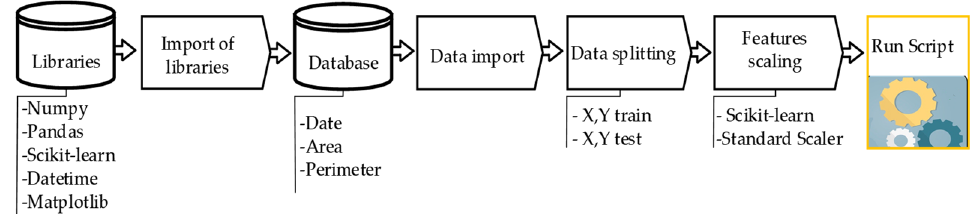
Figure 3. Methodological flow for the regression analysis.